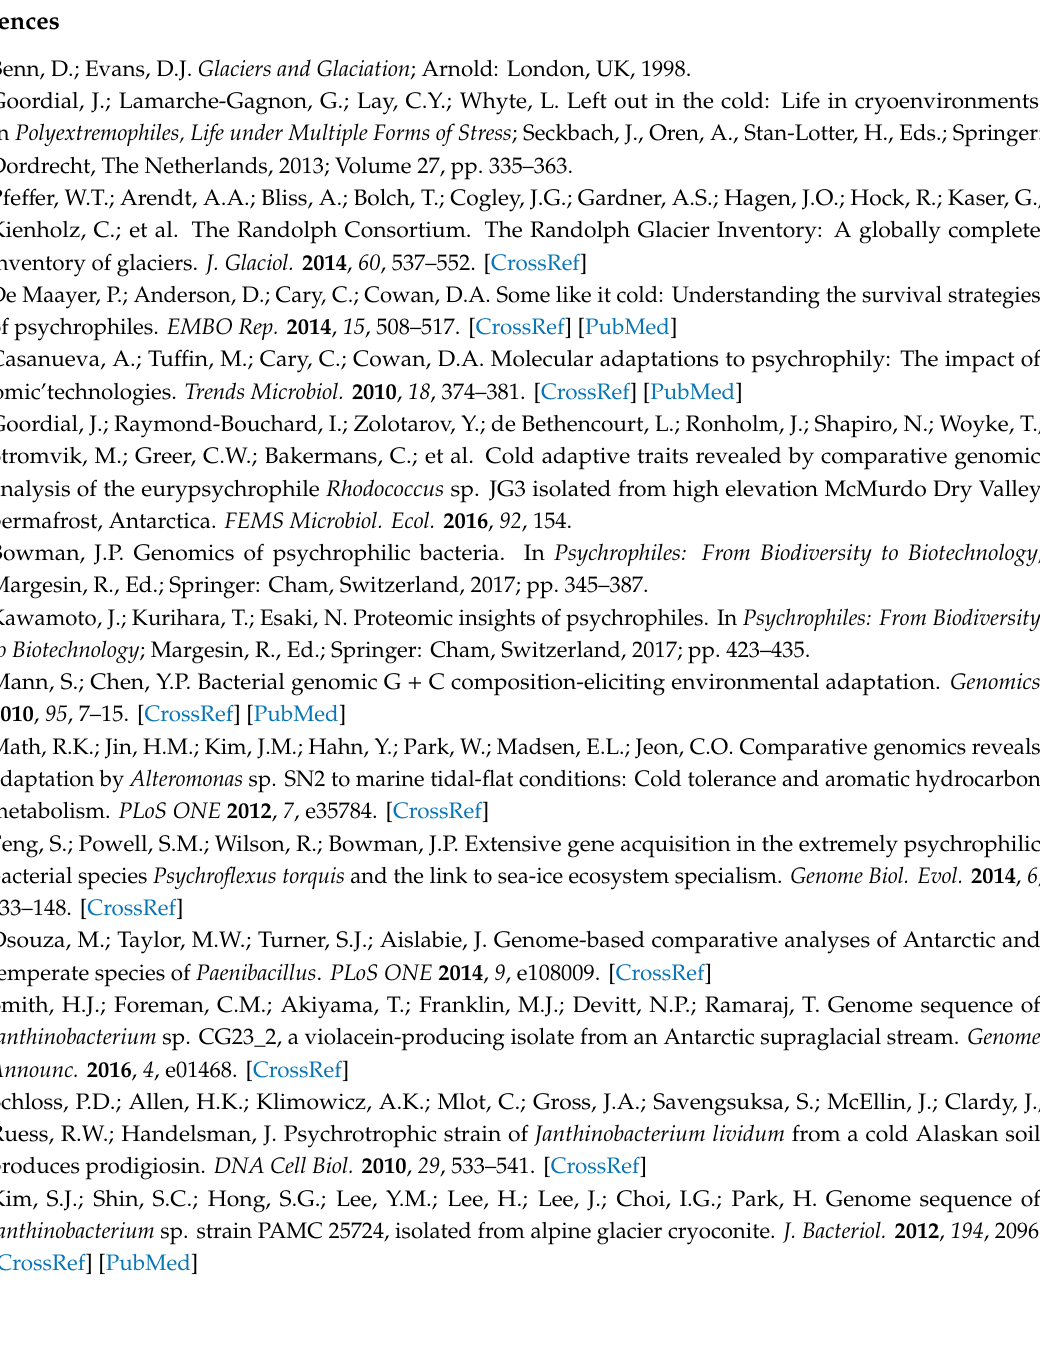
Supplemental Figure S1: 16S rRNA gene tree. Supplemental Table S1: Pairwise comparisons of coding sequences (CDSs) identified in 36 Janthinobacterium spp. Genomes. Supplemental Table S2: Results for sequences of in silico DNA–DNA hybridization (DDH) and average nucleotide identity (ANI). Supplemental Table S3: Function and COG category for cold-adapted protein-coding sequences in Janthinobacterium sp. CG23_2. Supplemental Table S4: List of clusters of orthologous groups